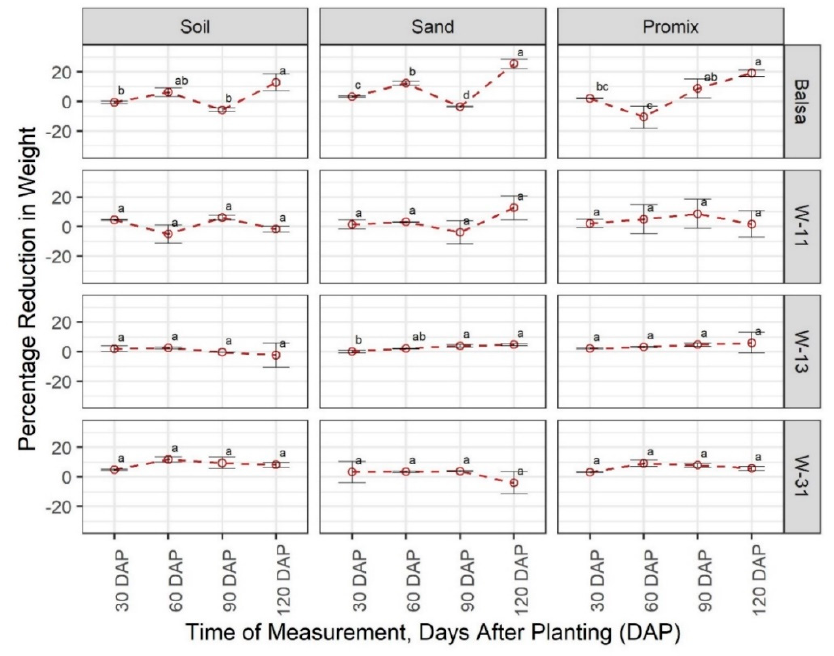
Figure 1. Comparison of the percentage change in material weight in three growing media (Promix, sand, and soil) at four growth stages (30, 60, 90, and 120 days after transplanting (DAP)). Different lowercase letters indicate significant differences in % weight change between different growth stages, at α = 0.05, within each growing media and material, whereas the same letters indicate no significant difference across compared treatments. W-11, 1:1 blend of beeswax and soy wax; W-13, 1:3 blend of beeswax and soy wax; and W-31, 3:1 blend of beeswax and soy wax.